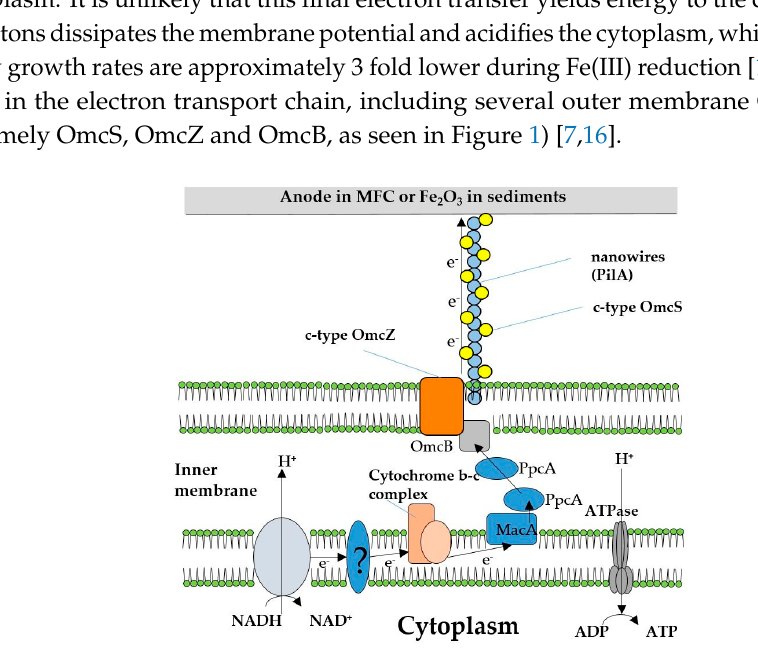
Figure 1. A schematic for the mechanism for extracellular electron transfer of Geobacter sulfurreducens (Adapted from [7,17]).